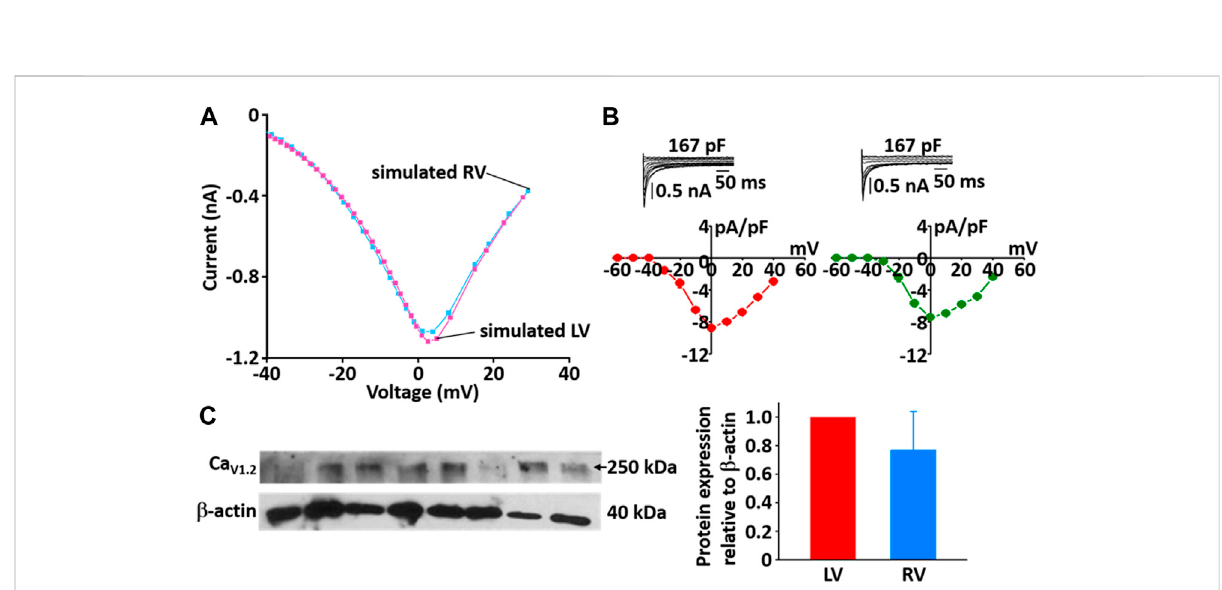
FIGURE 10 Comparison of I - V relationship of LCC in model (A) and experimental recordings (B) for LV and RV myocytes at 22 ° C (Kim, 2018). In panel (B) , inserts are representative ILCC traces from LV and RV myocytes and summary current-voltage relationships in LV ( n = 5, red circles) and RV ( n = 4, blue circles) myocytes, which from our previous study (Kim, Cannell et al., 2010). (C) Veri fi cation of protein expression of LCC proteins between LV and RV by immunoblotting. Representative blots and densitometric analysis of Ca v1.2 (250 kDa, n = 4) with β -actin (42 kDa) as housekeeping